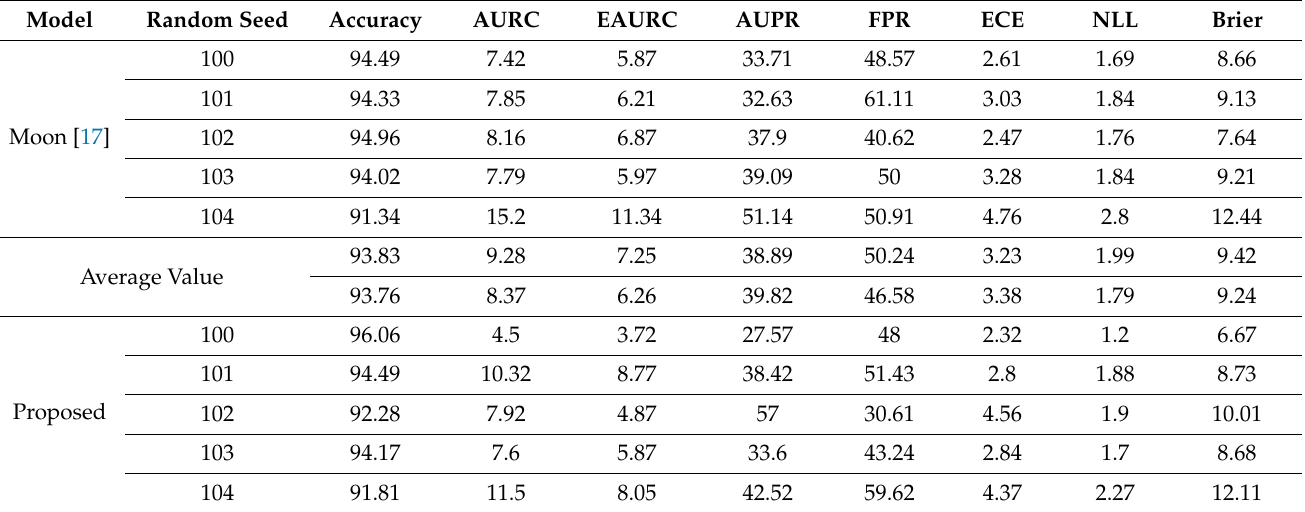
Table 4. Comparison between the improved method and the original method in the underwater image restoration